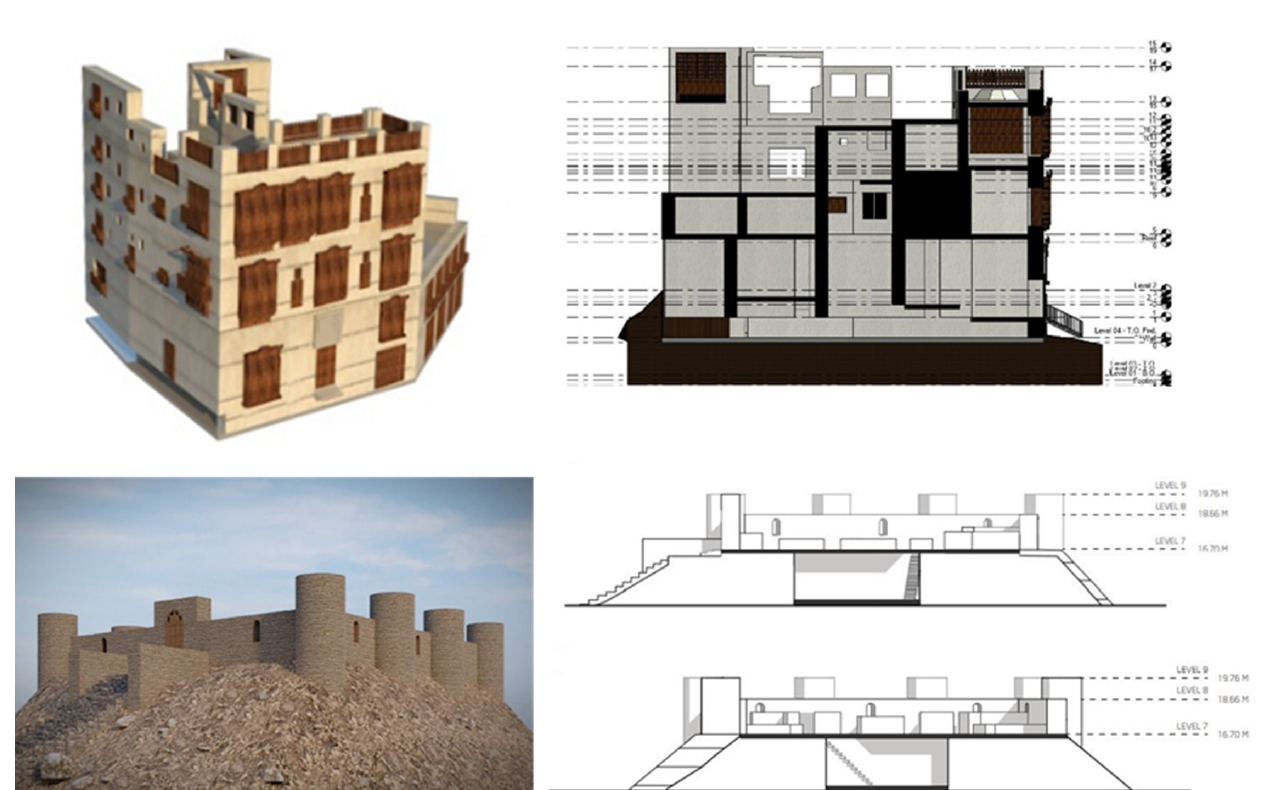
Figure 24. The final BIM models and their cross-sections.